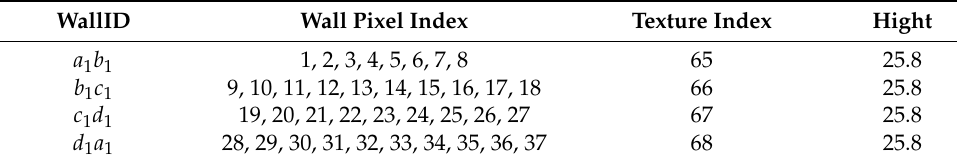
Table 4. The building wall texture index in Figure 7a. Table 5. The building wall texture index in Figure 7b. WallID WallID